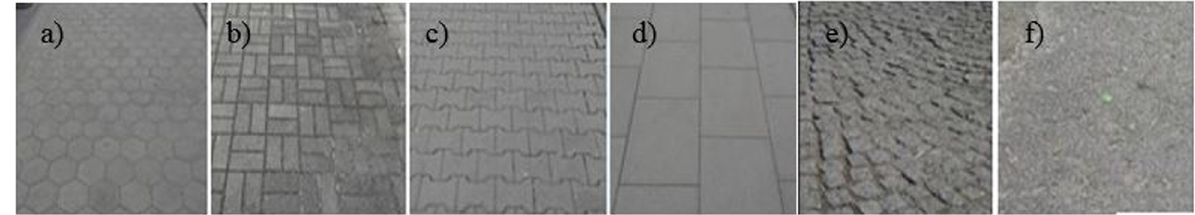
Figure 1: Types of surfaces used in the tests: ( a ) hexagonal slab, ( b ) “ mosaic ” paving stones, ( c ) “ bone ” paving stones, ( d ) 60 60 cm × slab, ( e ) granite cobblestones, and ( f )